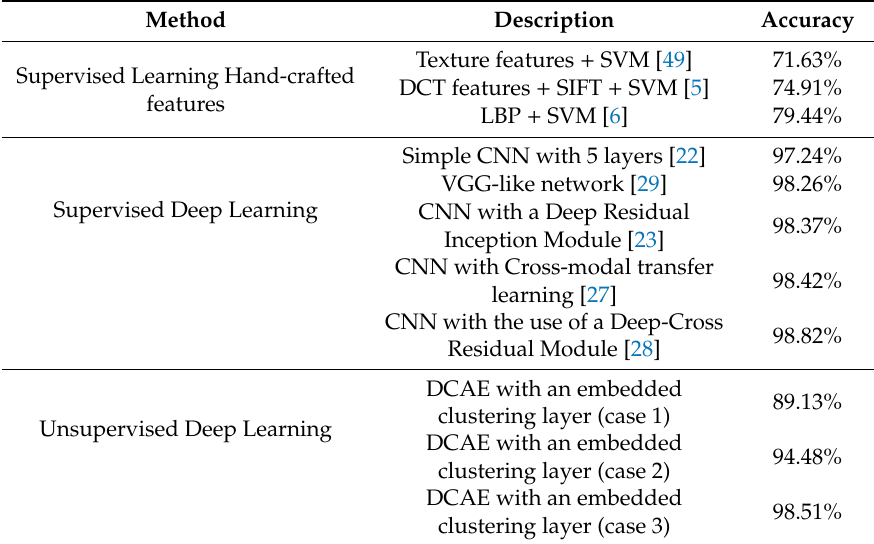
Table 3. Comparative study for the ICPR 2016